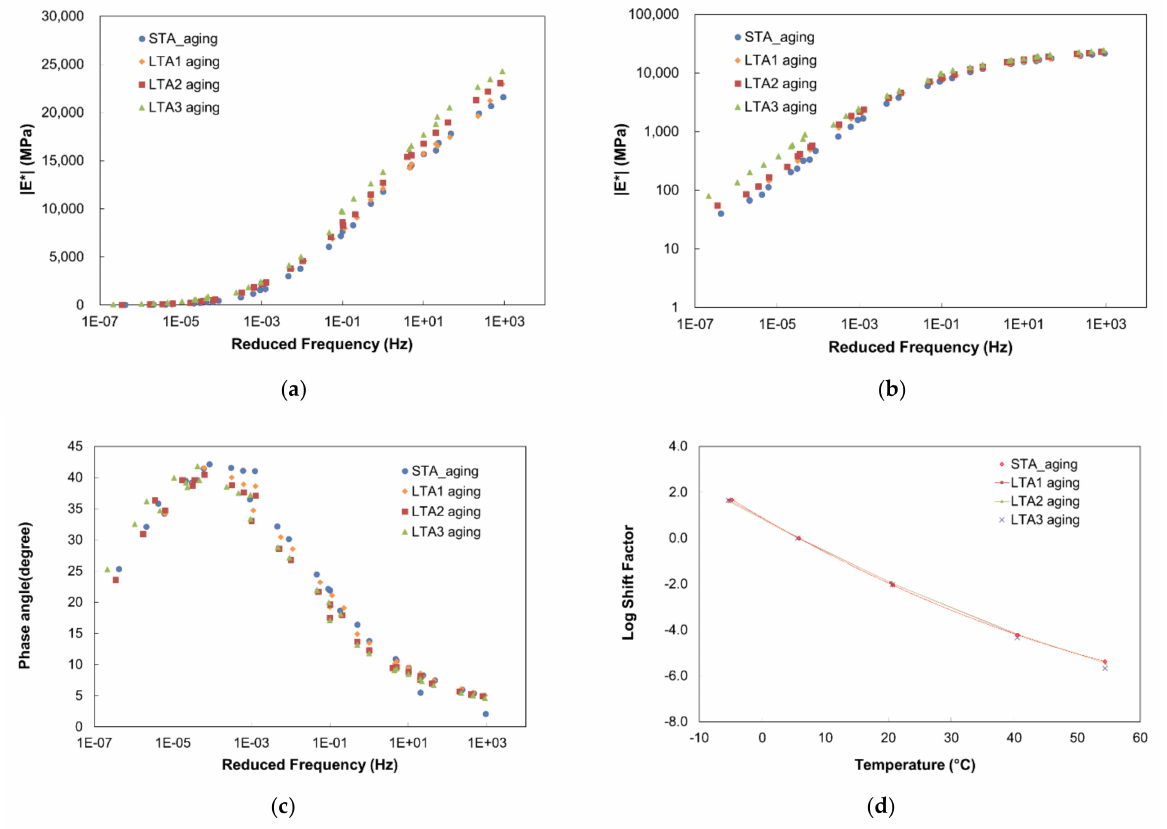
Figure 8. Dynamic modulus test results of HMA for each stage of aging: ( a ) dynamic modulus master curve (semi-log scale), ( b ) dynamic modulus master curve (log-log scale), ( c ) phase angle master curve, and ( d ) shift